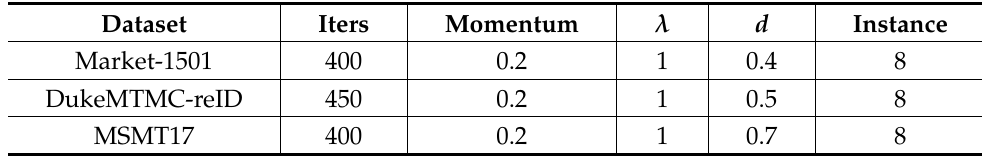
Table 4. Parameters for our method on different datasets.